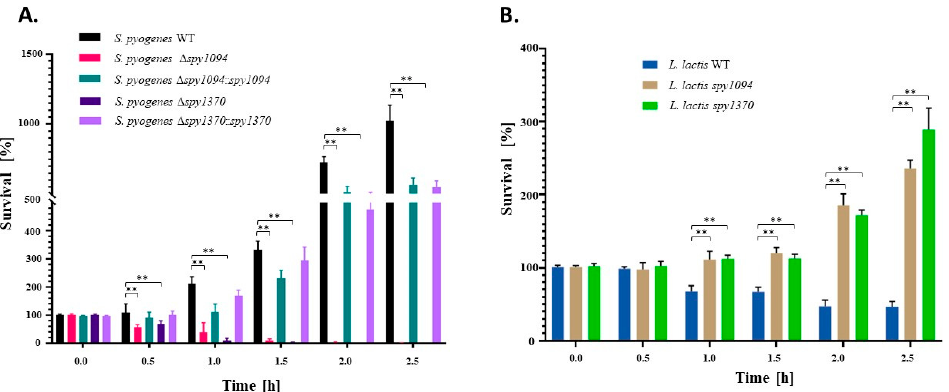
Figure 6. Survival of wildtype and mutant bacteria in whole human blood. Freshly collected human blood was inoculated with 1 × 10 5 CFU per ml with ( A ) S. pyogenes and mutant strains or ( B ) with L. lactis and mutant strains. Surviving bacteria were enumerated by spot ‐ plating in triplicates on BHI and GM17 agar plates, respectively. Data are mean values from two independent experiments with two different blood donors in triplicates +/ − SD for S. pyogenes ( A ). For L. lactis, one representative experiment in triplicates is shown and a second experiment with a different blood donor and a lower inoculation (1 × 10 3 CFU) is shown in supplementary Figure S1. p values were calculated using the one ‐ way ANOVA tests. ** p < 0.001.